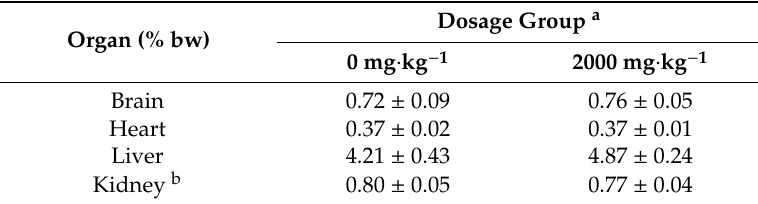
Table 6. Organ weights relative to body weight (g · 100 g − 1 bw) for female rats, after 14 days of being exposed to a single dose (2000 mg · kg − 1 ) of a food-grade extract from avocado seed (Avosafe ® ), with an acetogenin purity of